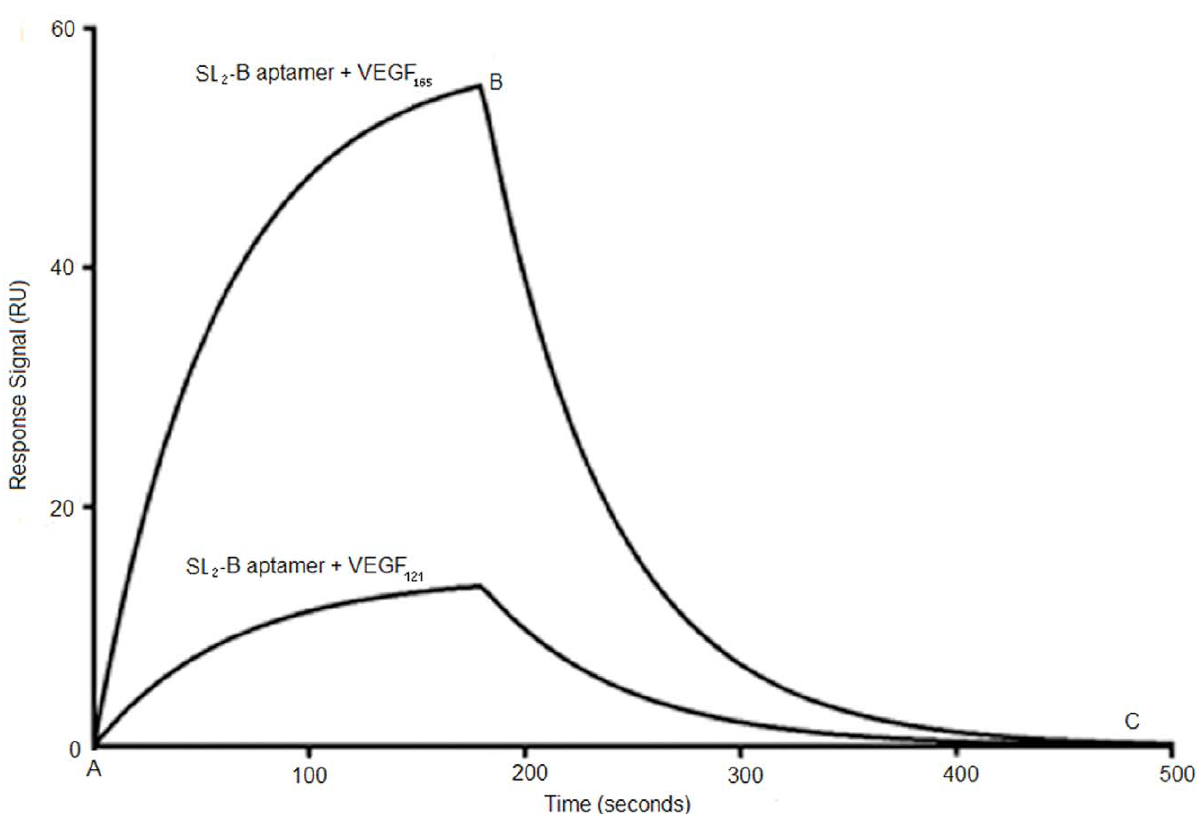
Figure 2. SPR sensorgrams demonstrating interaction of PS-modified SL 2 -B aptamer with immobilized VEGF 165 and VEGF 121 protein at same concentration. Point A to B corresponds to association phase and point B to C corresponds to the dissociation phase in both the sensorgrams. Shown here is PS-modified SL 2 -B aptamer binding with VEGF 165 protein (K d =0.56 6 0.44 nM) and VEGF 121 protein (K d =17 6 1.24 m M) at 80 nM aptamer concentration.